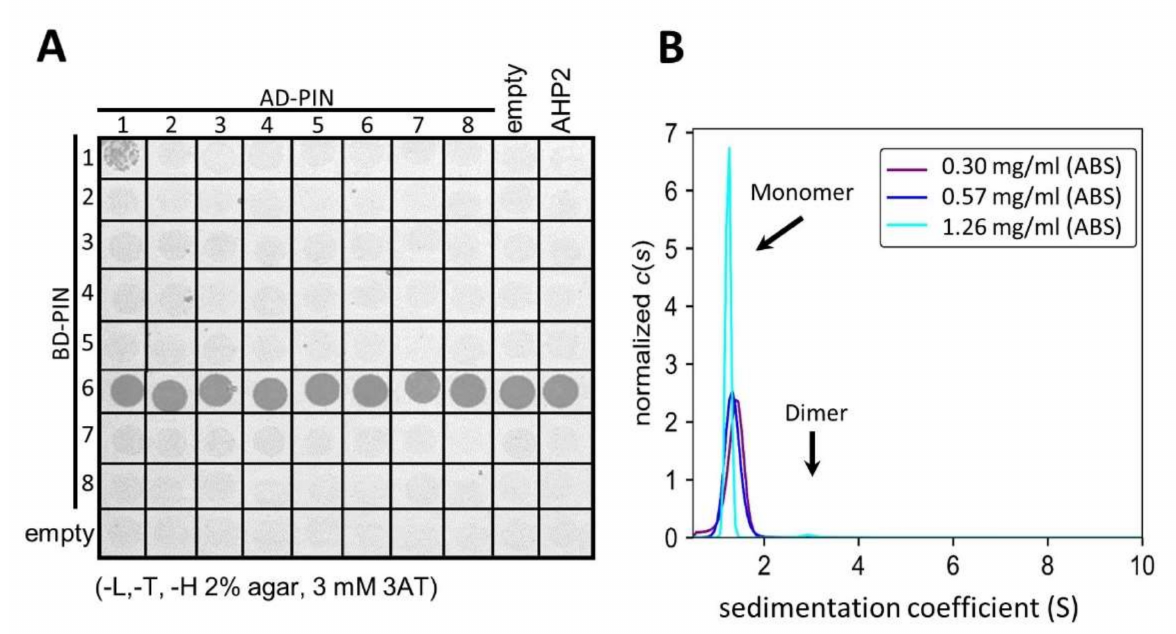
Figure 2. PIN1 hydrophilic loop homo-dimerizes while other long PIN loops do not. ( A ) A Yeast two-hybrid interaction assay of hydrophilic loops from PIN1 to PIN8 indicates the dimerization only for PIN1–HL. AHP2 as well as the empty plasmids containing only the activation domain (AD) and binding domain (BD) serve as negative interaction and growth control, respectively. Consistent auto-activation is observed for PIN6 HL. ( B ) Sedimentation velocity c( s ) distribution analysis of PIN1 HL–1. The arrows point at peaks corresponding to the monomeric and dimeric state of PIN1 HL–1. The concentrations in the right corner are color-coded corresponding to the curves drawn in the c( s ) distribution